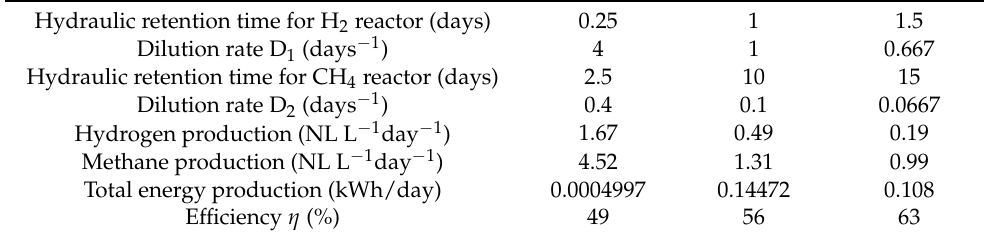
Table 6. Experimental conditions and results for the TPAD continuous tests ( γ = 0.1). Hydraulic retention time for H 2 reactor